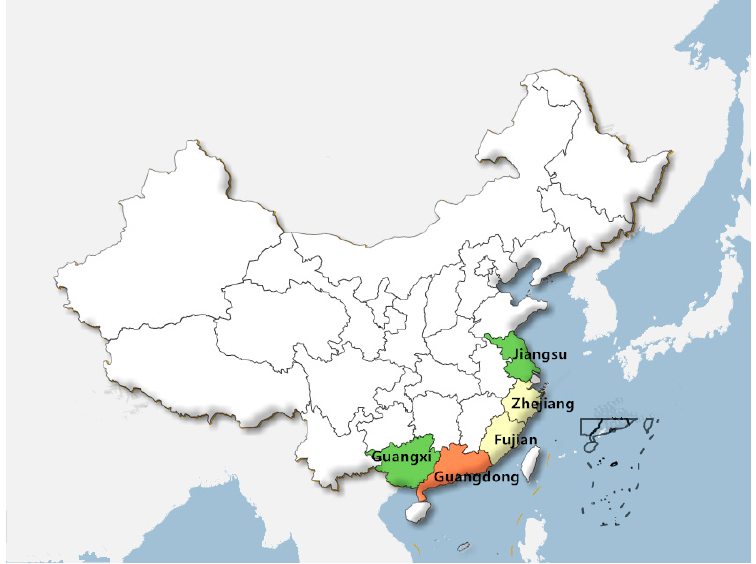
Figure 5. The regional characteristics of China coast main five provinces about storm surge. Different colors show that the relational degree of every loss and economic loss is different, the same color show the relational degree is similar.